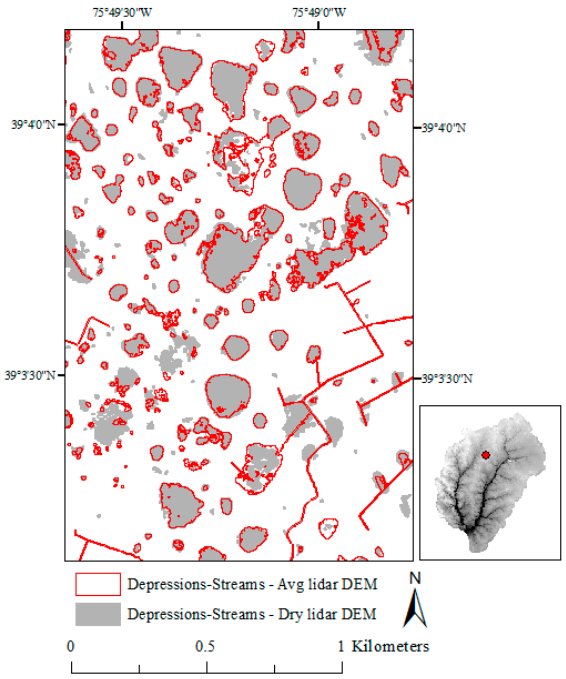
Figure 5. The extent of the depressions as derived from a dry versus an average wetness condition lidar digital elevation model (DEM).